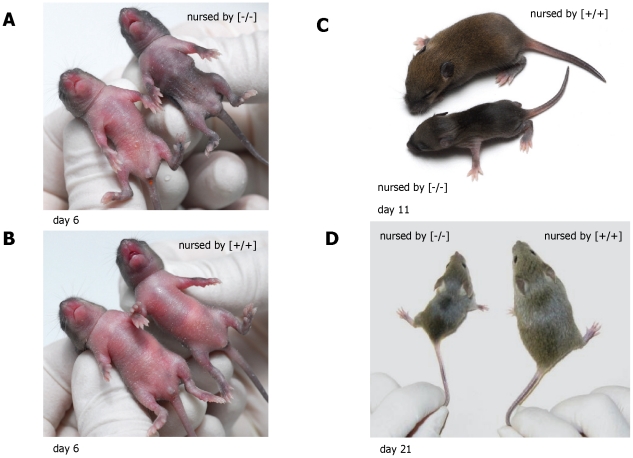
Photographs of experimental animals.
Panel A: Photograph of wild-type mice nursed by α-casein deficient [−/−] dams (at age of 6 days). Panel B: Photograph of heterozygous offspring nursed by wild-type dams (at age of 6 days). Panel C: Photograph of mice nursed by wild-type and α-casein deficient dams at 11 days of age. Panel D: Photograph of mice nursed by wild-type and α-casein deficient dams at 21 days of age.